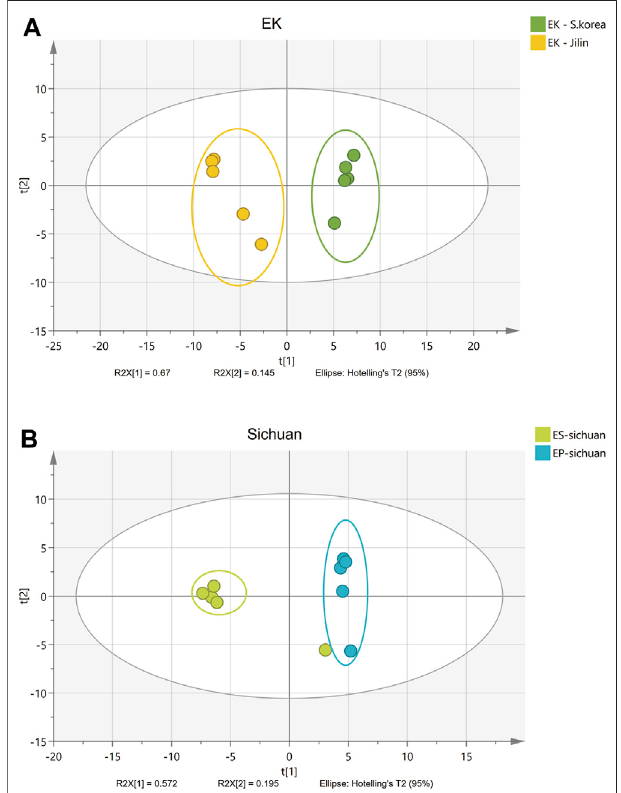
FIGURE 3 | PCA scores plot (A) and loadings plot (B) of Epimedium samples. In the scores plot, Epimedium species are represented by different shapes, and each data point is colored according toits amount ofepimedin C and labeled with its geographical origin (SK — South Korea, LG — Longnan Gansu, WG — Weiyuan Gansu, Ji — Jilin, Si — Sichuan, Sh — Shaanxi). Ellipses indicate sample groups based on species or geographical origin; dashed-line circles indicate outliers (two E. brevicornum outliers from Weiyuan Gansu, one E. sagittatum outlier and another E. pubescens both from Sichuan). The loadings plot (B) shows the compounds responsible for the group separation; for clarity, the peak numbers corresponding to epimedin C, icariin and baohuoside I were substituted by their name.